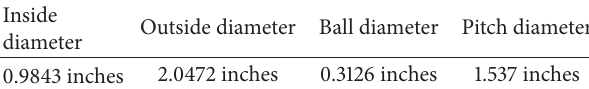
Table 1: Parameters of 6205-RS JEM